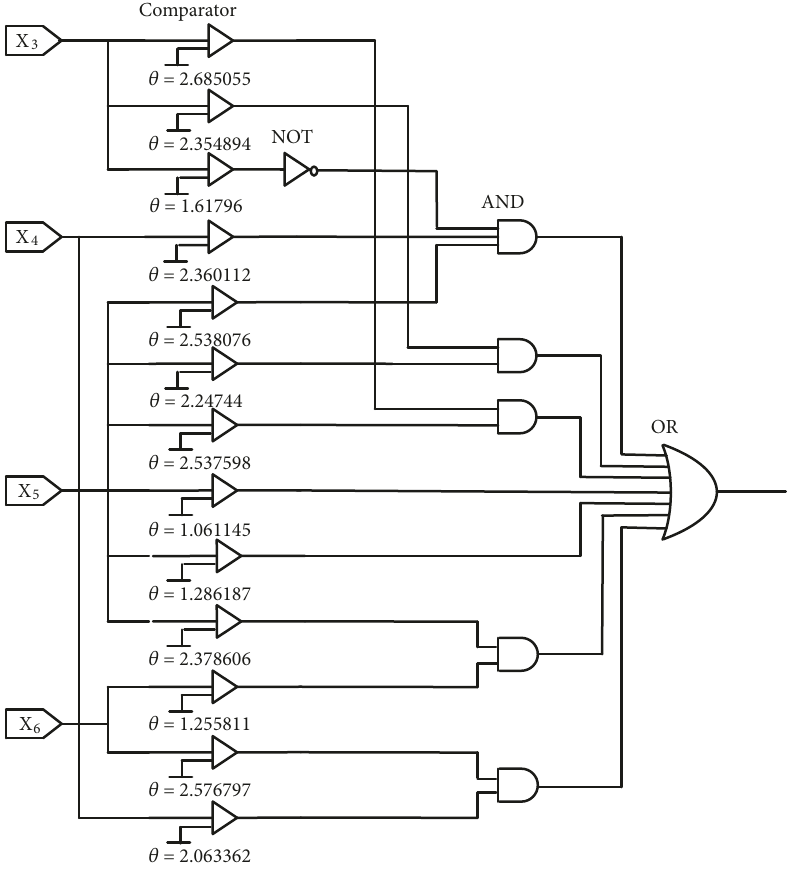
Figure 16: The logic circuit of the Qualitative Bankruptcy data